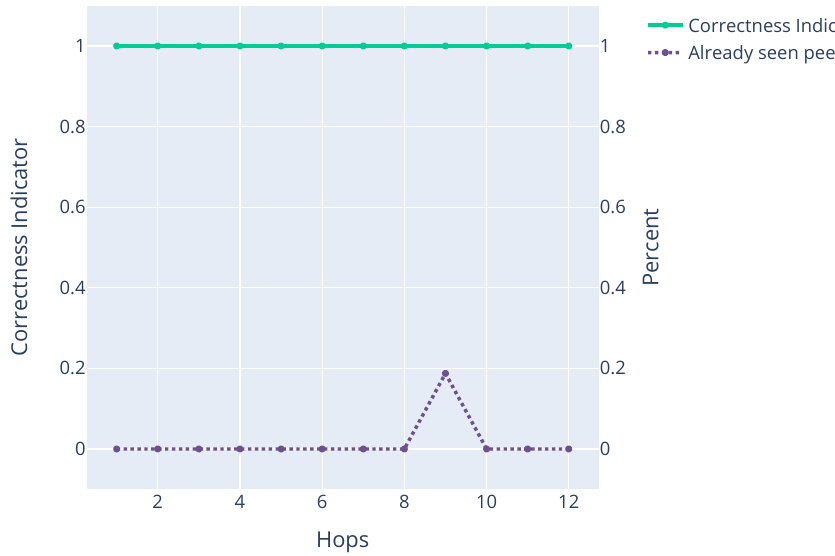
Figure 4. Example mainnet experiment when a small number of previously seen nodes were ex- changed in APRES messages as the number of hops